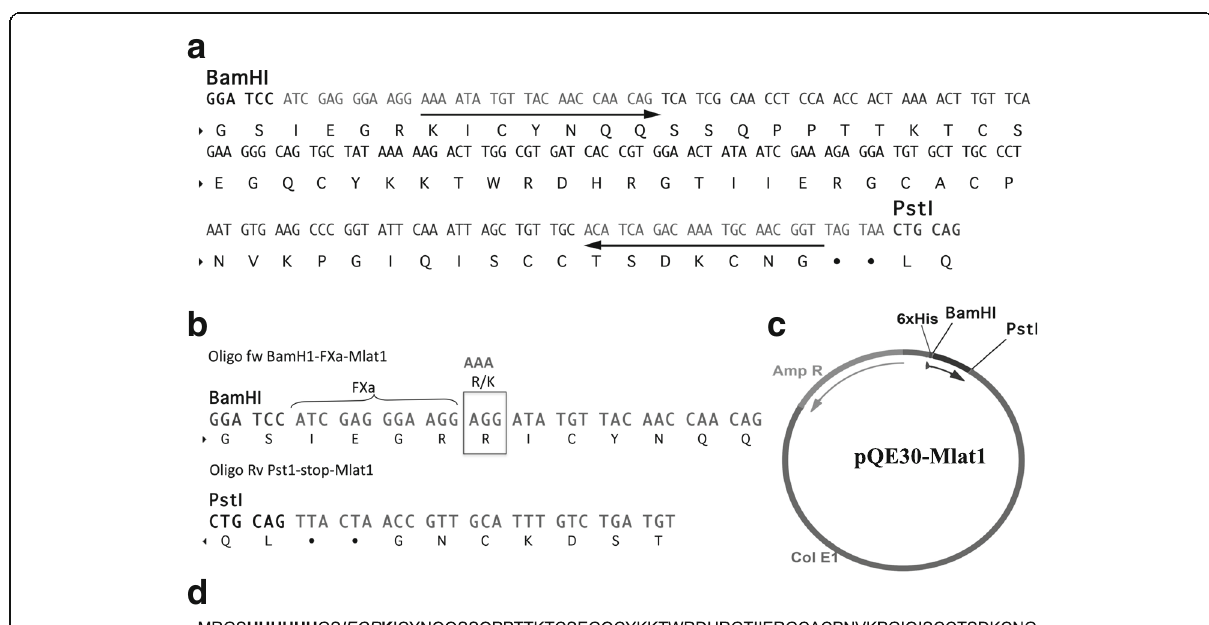
Fig. 1 Gene construction of the plasmid carrying HisrMlat1. a The nucleotide and amino acid sequence of HisrMlat1. b The nucleotide and amino acid sequence of HisrMlat1 after modification of the Arg N-terminal. c Scheme of the expression vector pQE30XaHisrMlat1. The His-tag is part of the 5 ′ -nucleotide sequence of pQE30, in such a manner that the sequence to be expressed is the one shown, in which the cleavage site for the restriction enzyme is indicated (BamHI and PstI). d Amino acid sequence of HisrMlat1. The His-tag is in bold, the FXa cleavage site is in italics and the modification of the residue Lys is in